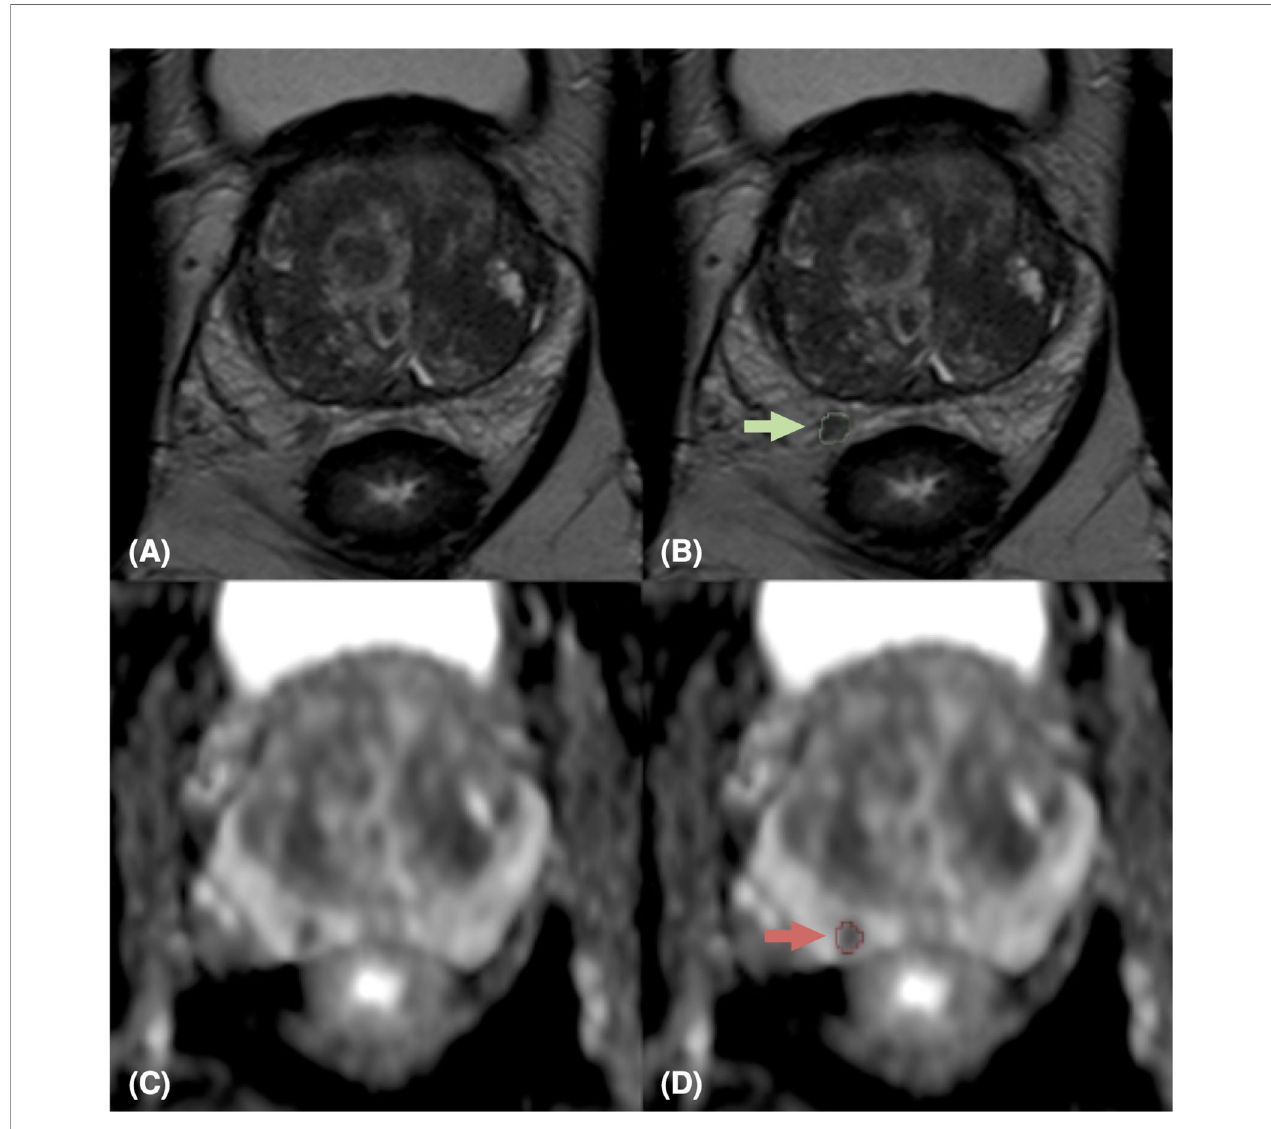
FIGURE 1 | MpMRI of a 76-years old patient with indeterminate mpMRI result (PI-RADS=4), PSA=14 ng/ml, GS=4+4 (ISUP 4). MpMRI zoomed images containing the target lesion, respectively axial T2-weighted image (A) , ADC map (C) , and their relative lesion segmentations (B, D) . The green (B) and red (D) arrows point out the segmented lesion in T2 and ADC images,